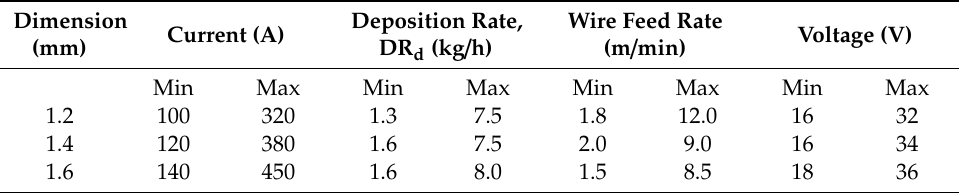
Table 1. Feedstock commercial data sheet (OK TUBROD 14.03).